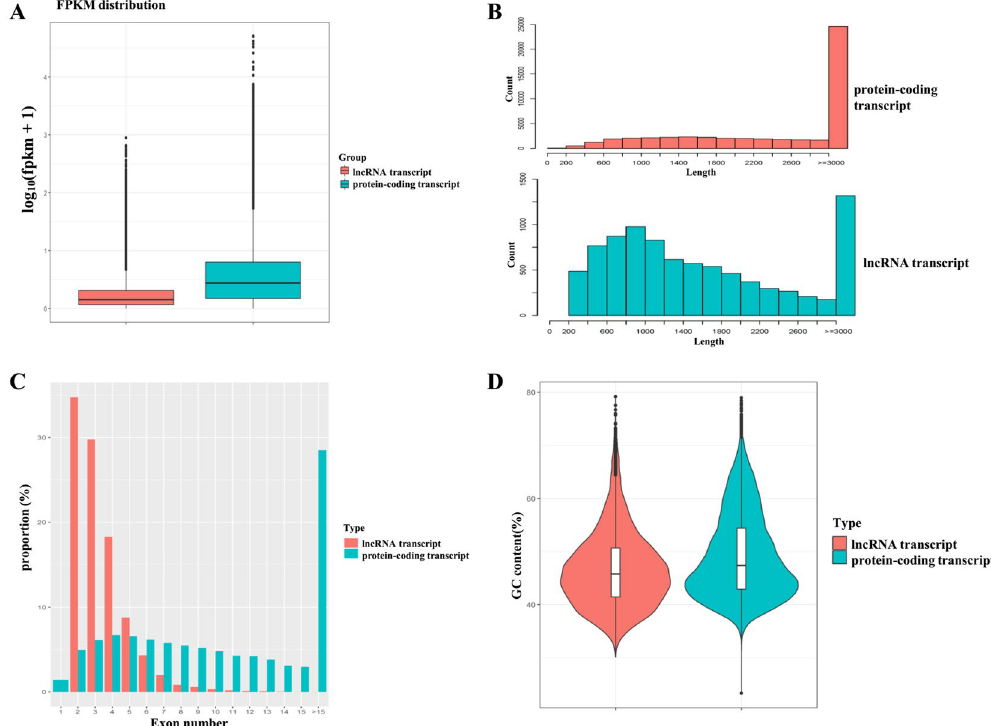
Figure 2. Overview of RNA sequencing in the chicken ovary. ( A ) The boxplot of FPKM (Fragment Per Kilobase of transcript per Million mapped reads) for protein-coding and lncRNA transcripts; ( B ) The distribution of read lengths for protein-coding and lncRNA transcripts. ( C ) The proportions of exons’ number per transcript for protein-coding and lncRNA transcripts. ( D ) The GC content of protein-coding and lncRNA